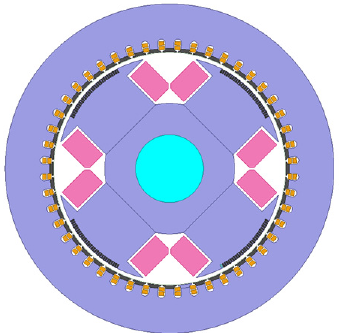
Figure 2. FEA model of the generator.